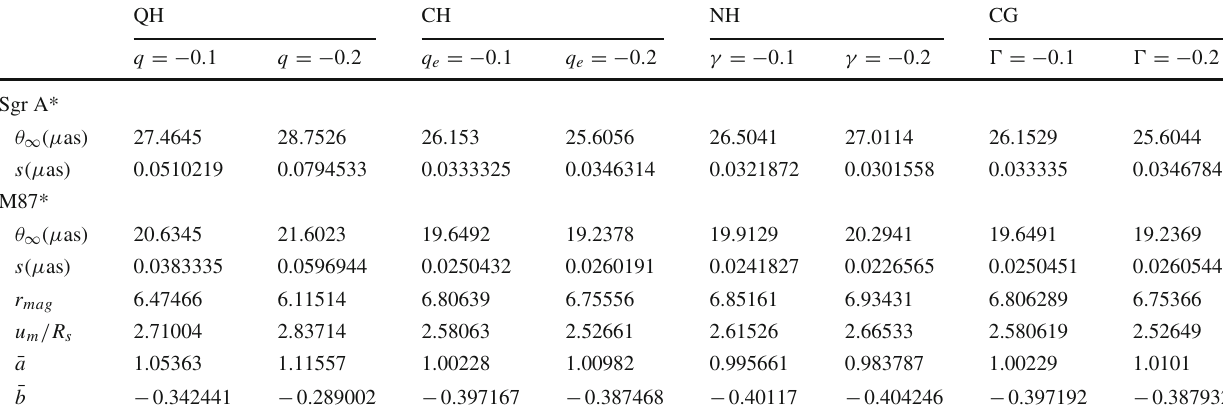
Table 8 The lensing Observables θ ∞ , s , r mag , lensing coefficients ¯ a , ¯ b and critical impact parameter u m for QH, CH, NH and CG by modelling them as Sgr A* and M87* black holes. r mag , ¯ a , ¯ b are dimensionless whereas u m is in the units of Schwarzschild radius R s = 2 GM / c 2